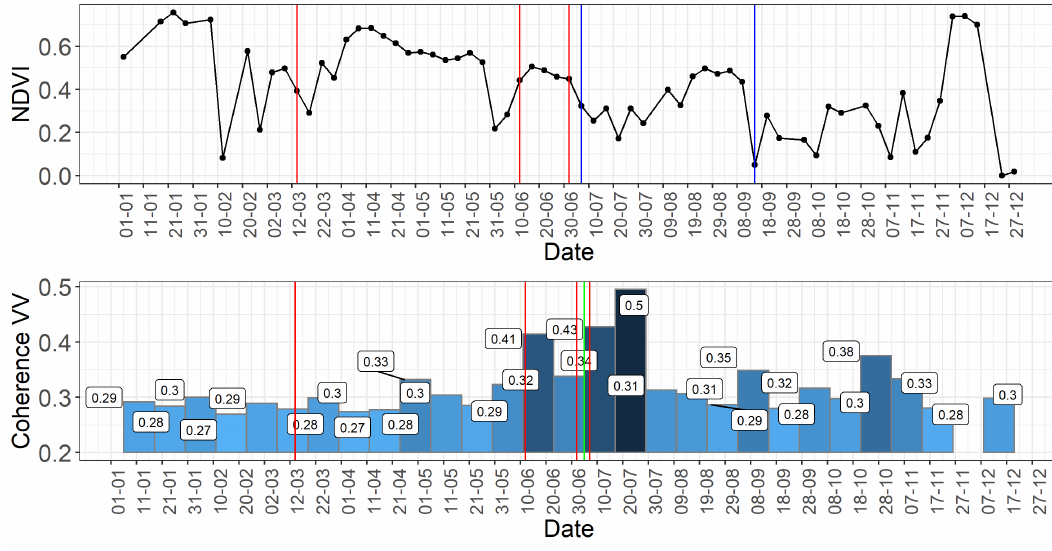
Figure 21. Example of the harvest date omission by the SAR algorithm due to nonagricultural lands within the parcel (cid = 163). Actual harvest dates (red lines): 14 March 2018, 12 June 2018, 2 July 2018, and 7 July 2018; harvest dates according to the optical algorithm (blue lines): 7 July 2018 and 15 September 2018; harvest date according to the SAR algorithm (green line): 5 July